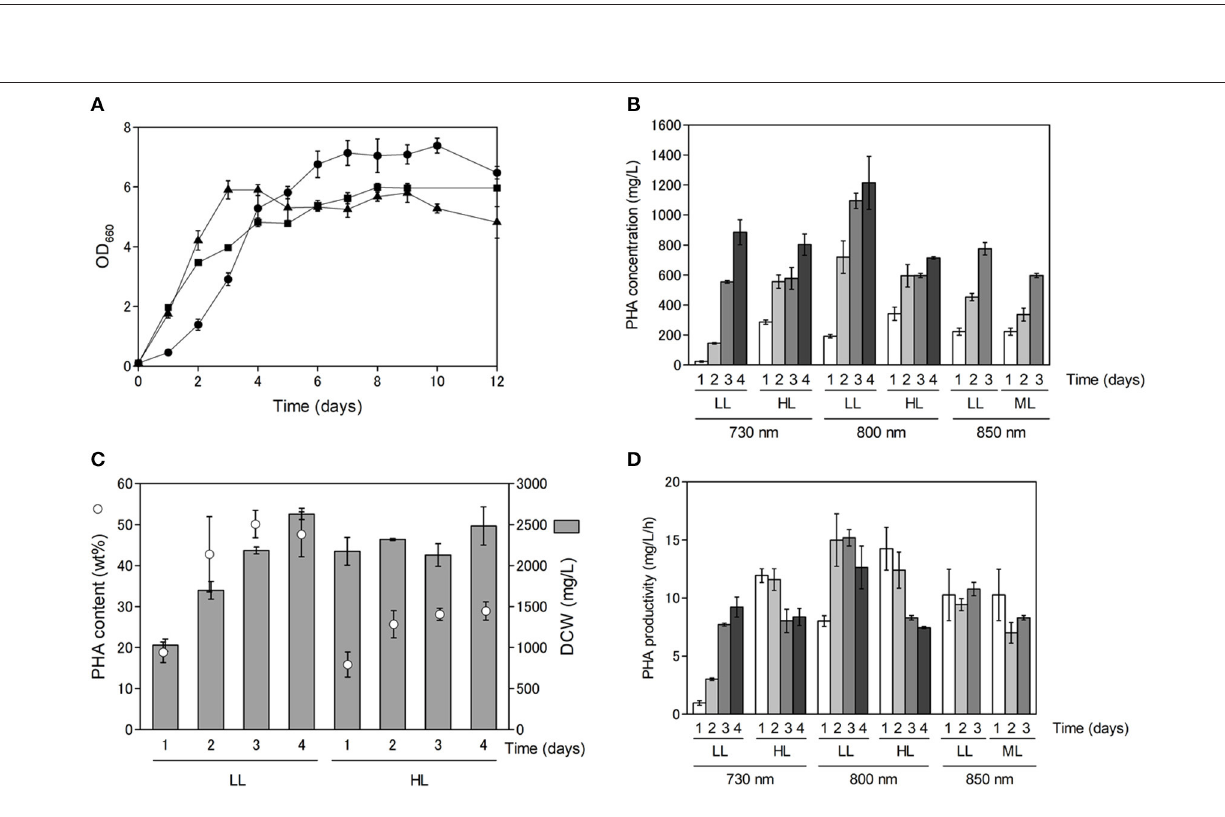
Frontiers in Bioengineering and Biotechnology |